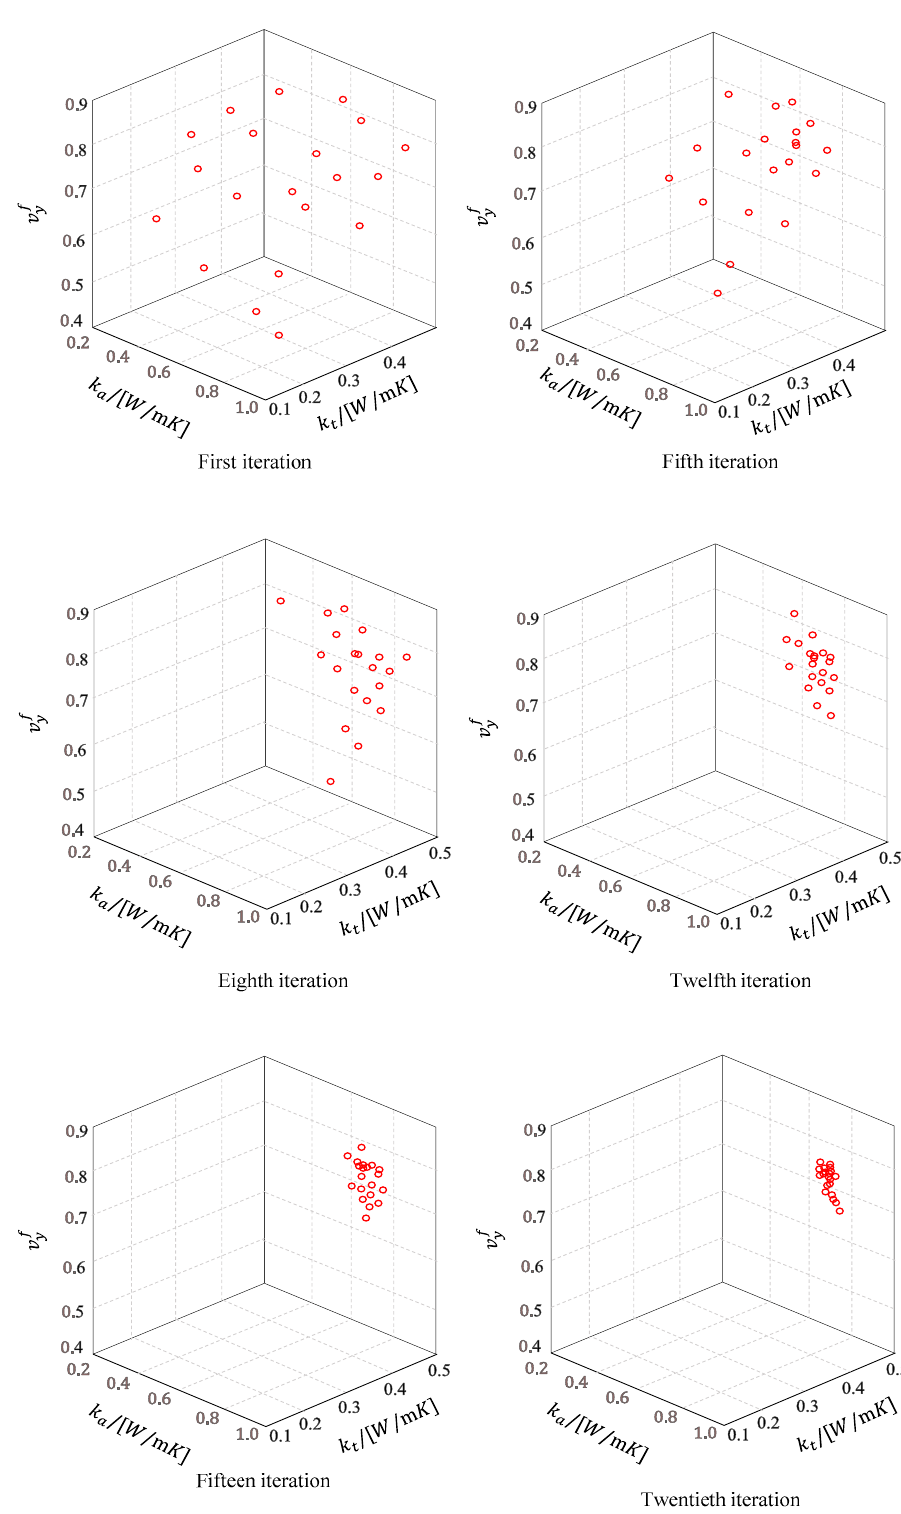
Figure 5. Particle positions of different iterations.